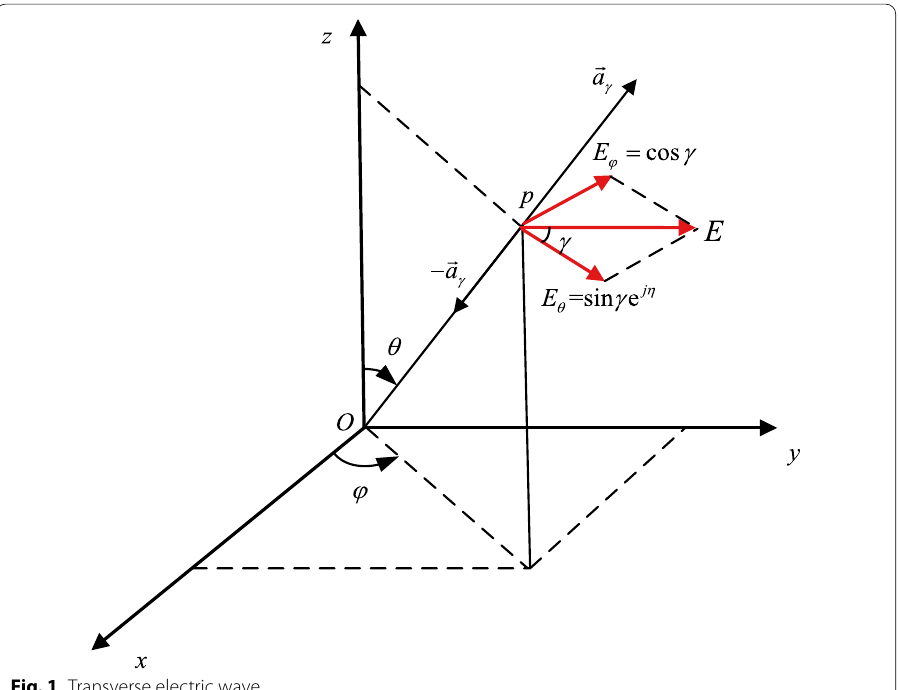
Fig. 1 Transverse electric